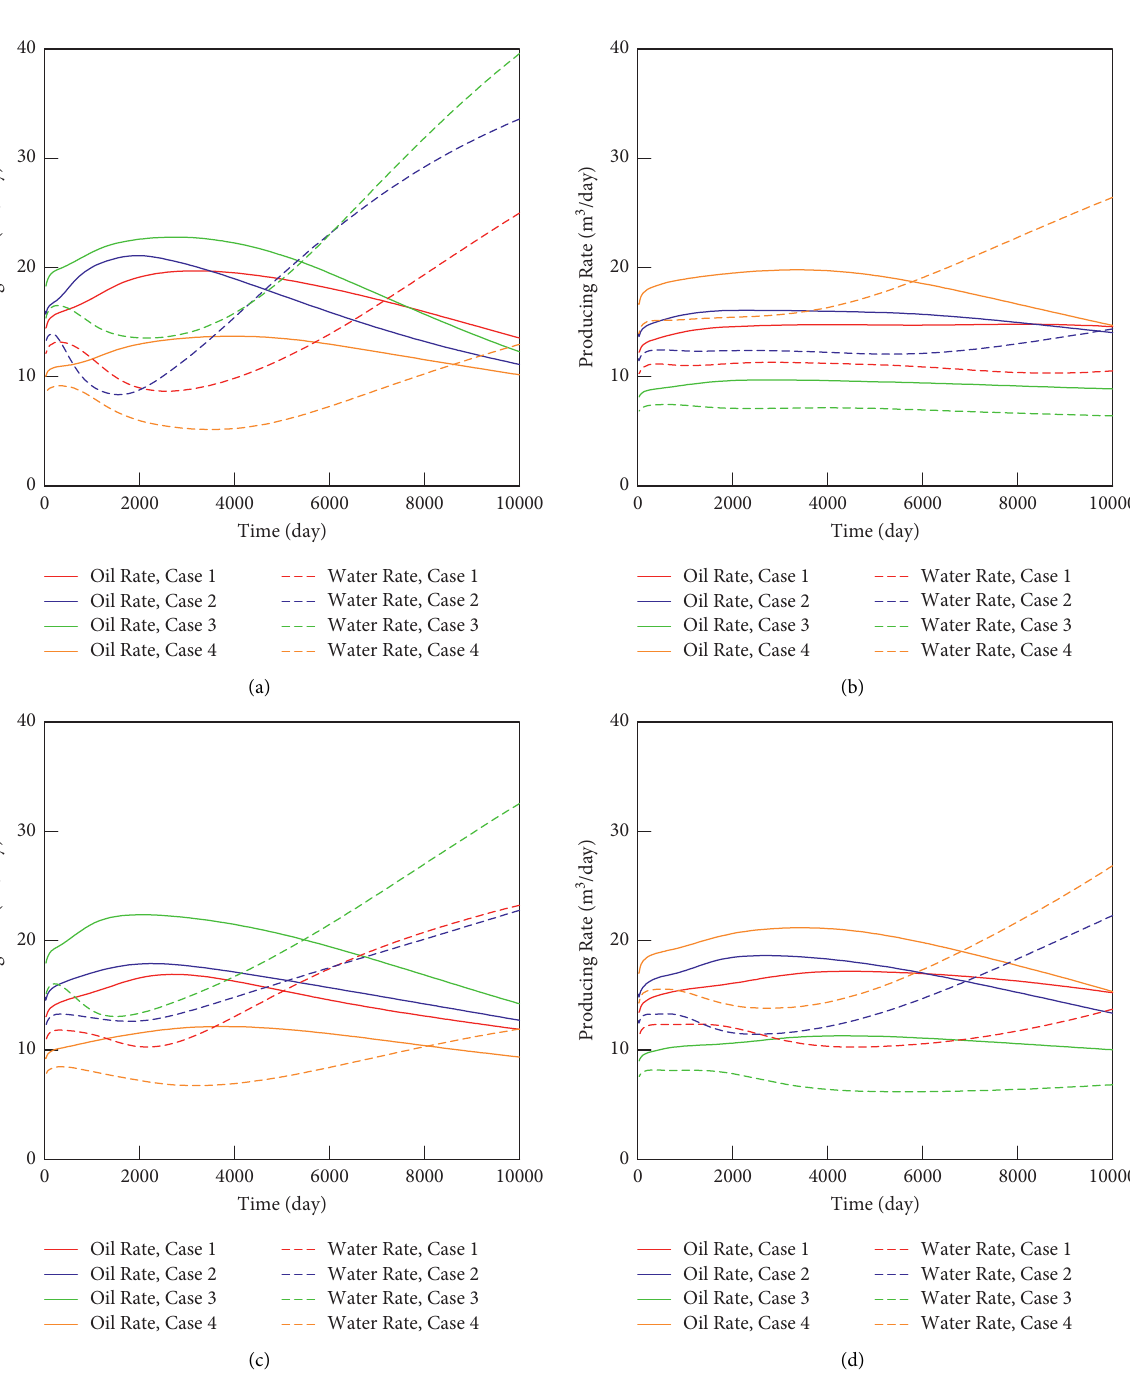
Figure 27: Histories of producing rate from (a) well 1, (b) well 2, (c) well 3, and (d) well